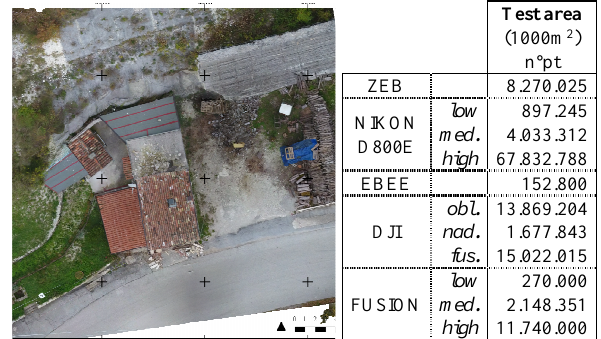
Figure 10. Test area (Point cloud data on Table